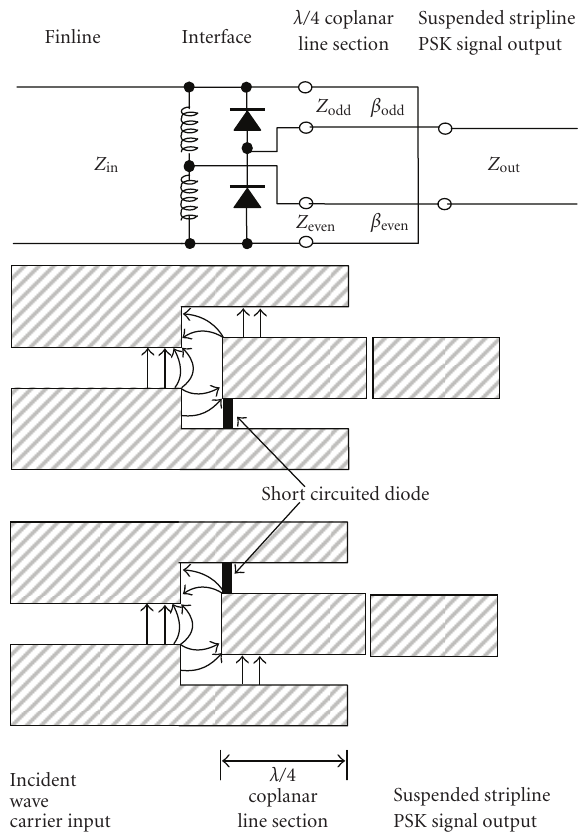
Figure 2: Equivalent circuit of the balanced BPSK